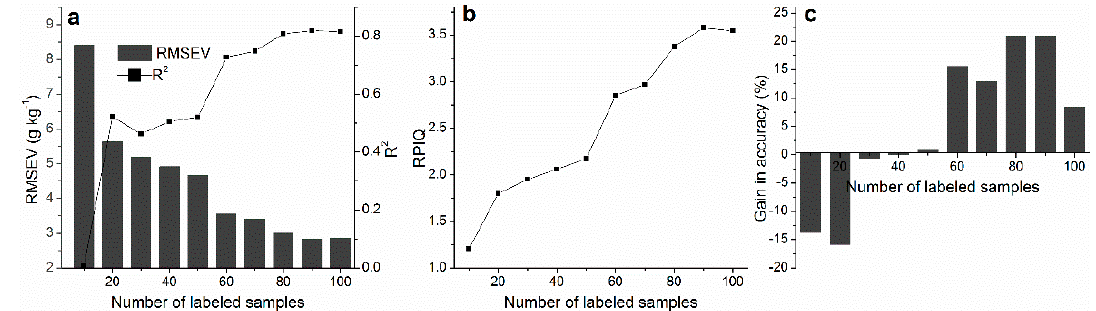
Figure 11. The performance of: Co-LSSVMR ( a ); RPIQ of Co-LSSVMR ( b ); and the gains in accuracy obtained by Co-LSSVMR with respect to LSSVMR ( c ) versus the number of labeled samples with 64 unlabeled samples available for exploitation.